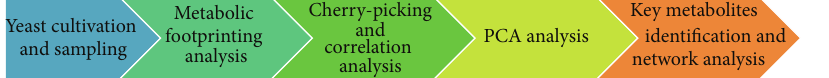
Figure 1: The pipeline for our dynamic metabolic footprinting process. Different perturbations are imposed on the microorganism, for example, growth on different carbon sources or parallel analysis of different mutants, and the growth profile is recorded using at least 10 samples. The samples are processed and analyzed using DI-MS. The resulting spectra are processed to obtain correlation between different metabolites analyzed.